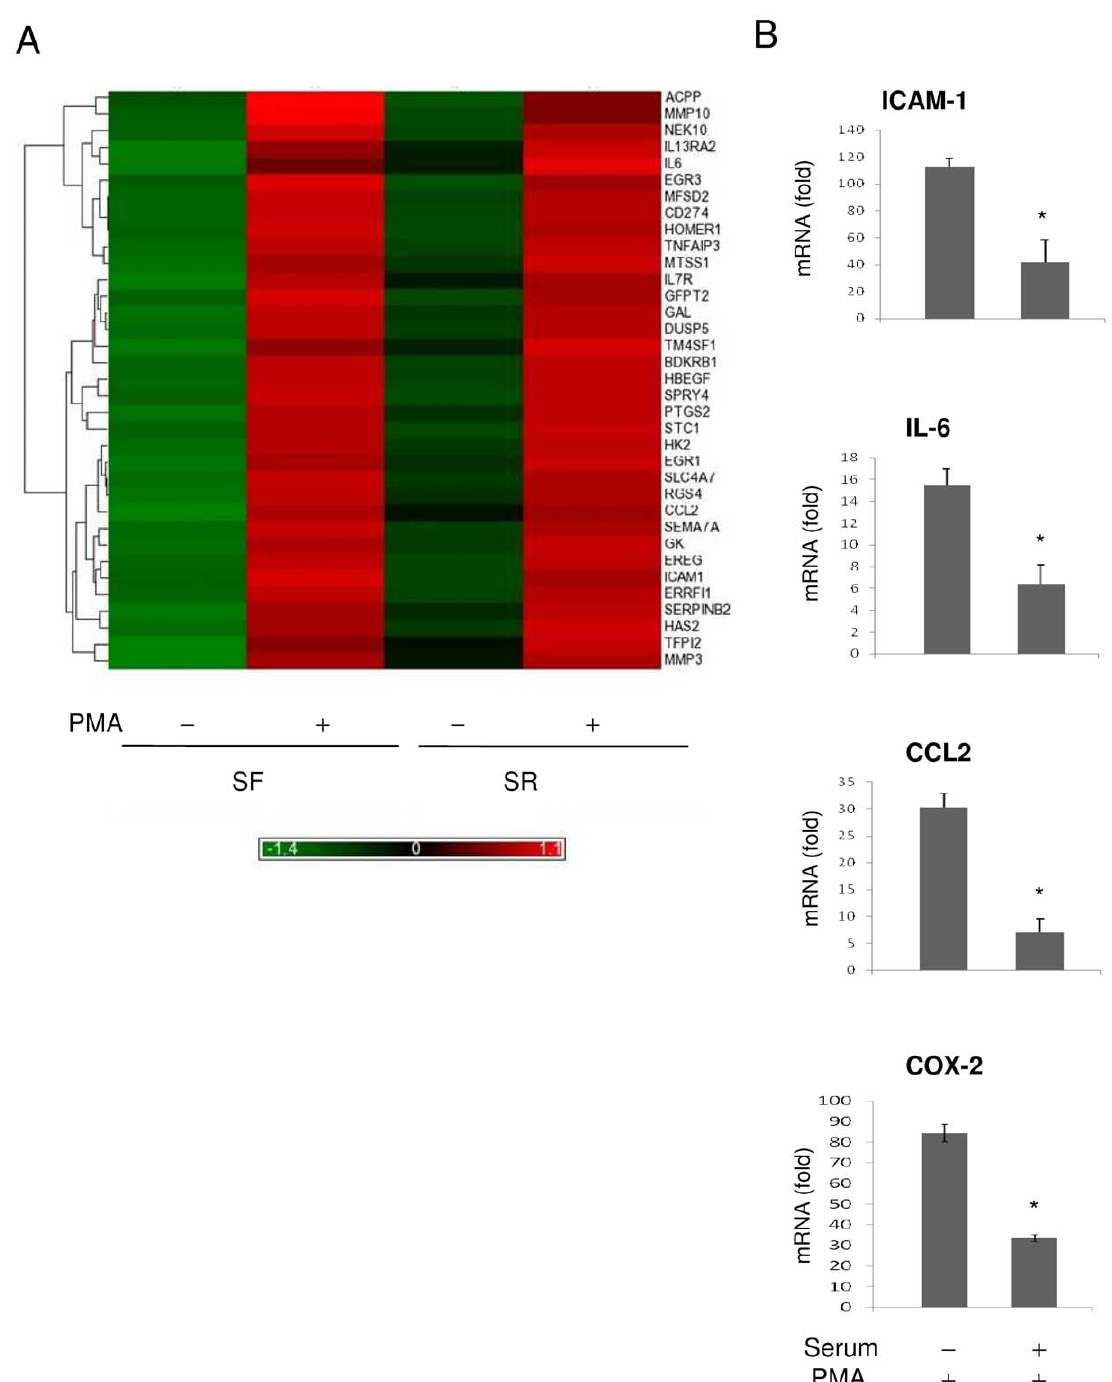
Figure 9. Gene expression profiling in SF- vs. SR-HsFb. ( A ) Heat map shows the genes with differential expression between SF- and SR-HsFb treated with PMA. Gene names are listed at the right margin of the map. ( B ) Validation by quantitative PCR. mRNA levels of several proinflammatory genes in SF- vs. SR-HsFb were measured by qPCR. Error bars are mean 6 SEM (n=3). * p , 0.05 compared to SF-cells.